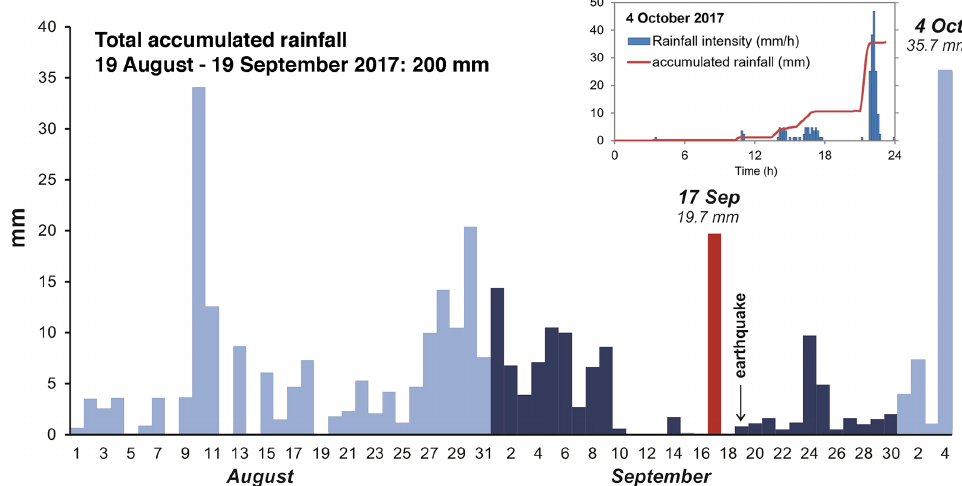
Figure 10. Rainfall measurements at rain gauge ALTZ from 1 August to 4 October 2017. A total accumulated rainfall of 200mm was recorded during the 30d preceding the earthquake, 19.7mm of which was on 17 September 2017 (red bar). On 4 October 2017, the population of San Juan Tehuixtitlán noticed the passage of sediment-laden flow in the Hueyatlaco ravine.